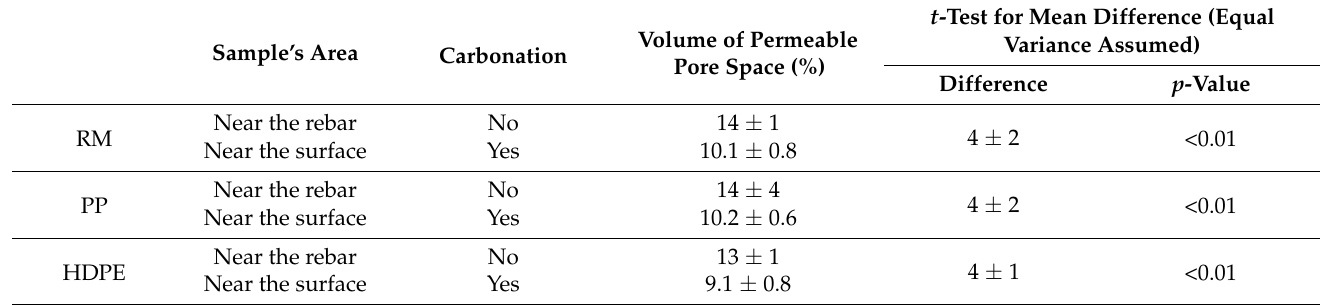
Table 3. Volume of permeable pore space and testing on the effect of carbonation on its value.